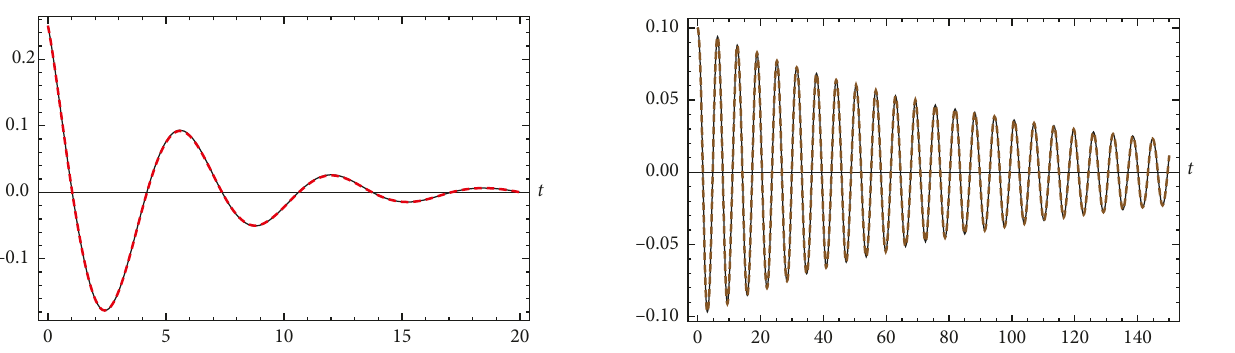
Figure 7: Comparison between the approximate analytical solution and the numerical solution for Example 7.